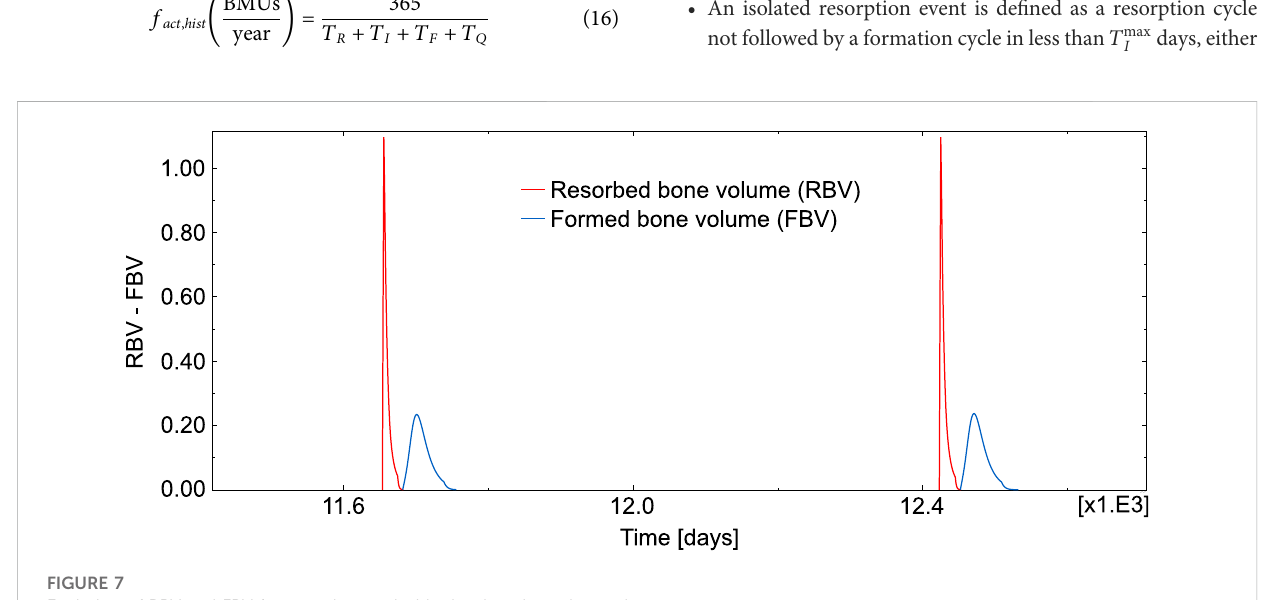
FIGURE 7 Evolution of RBV and FBV for one element inside the domain under